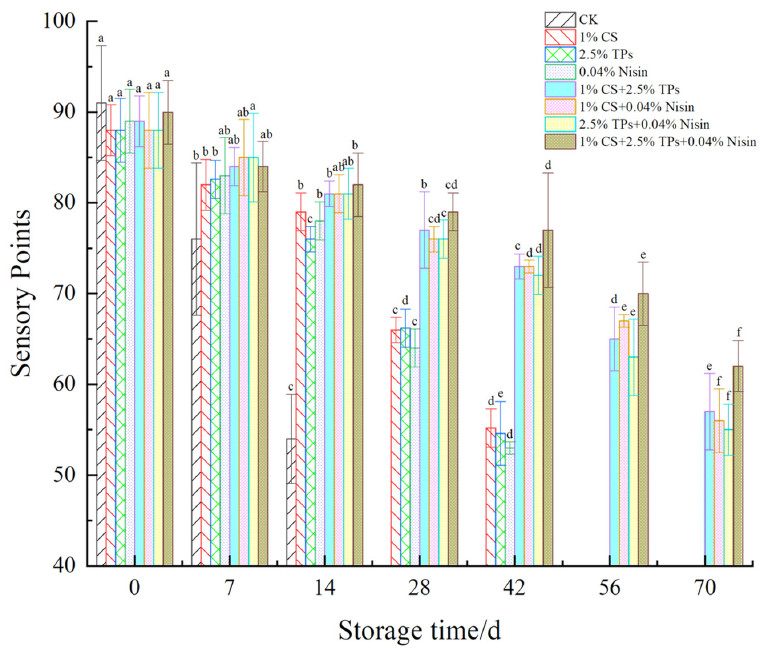
Figure 3. Effects of compound preservatives on the sensory scores of plant-based meat. a–f Values with different superscripts in the same preservative indicate significant differences ( p < 0.05). CS, chitosan; TP, tea polyphenols; CK, control